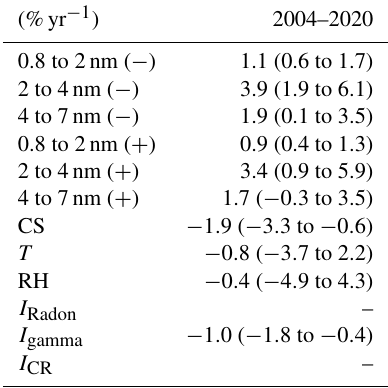
Table 3. The relative change in ion concentration for BSMA for 2004–2020. The relative changes per year have been calculated from Sen’s slopes. The values in brackets are the confidence in- tervals for the trend at a 90%